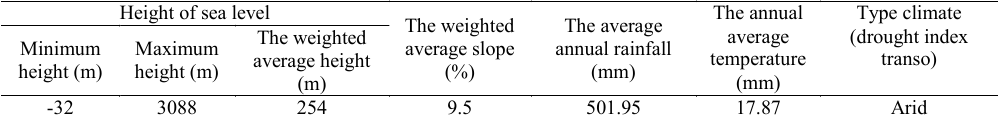
Table 1: Topographic and climatic characteristics of the study area Height of sea